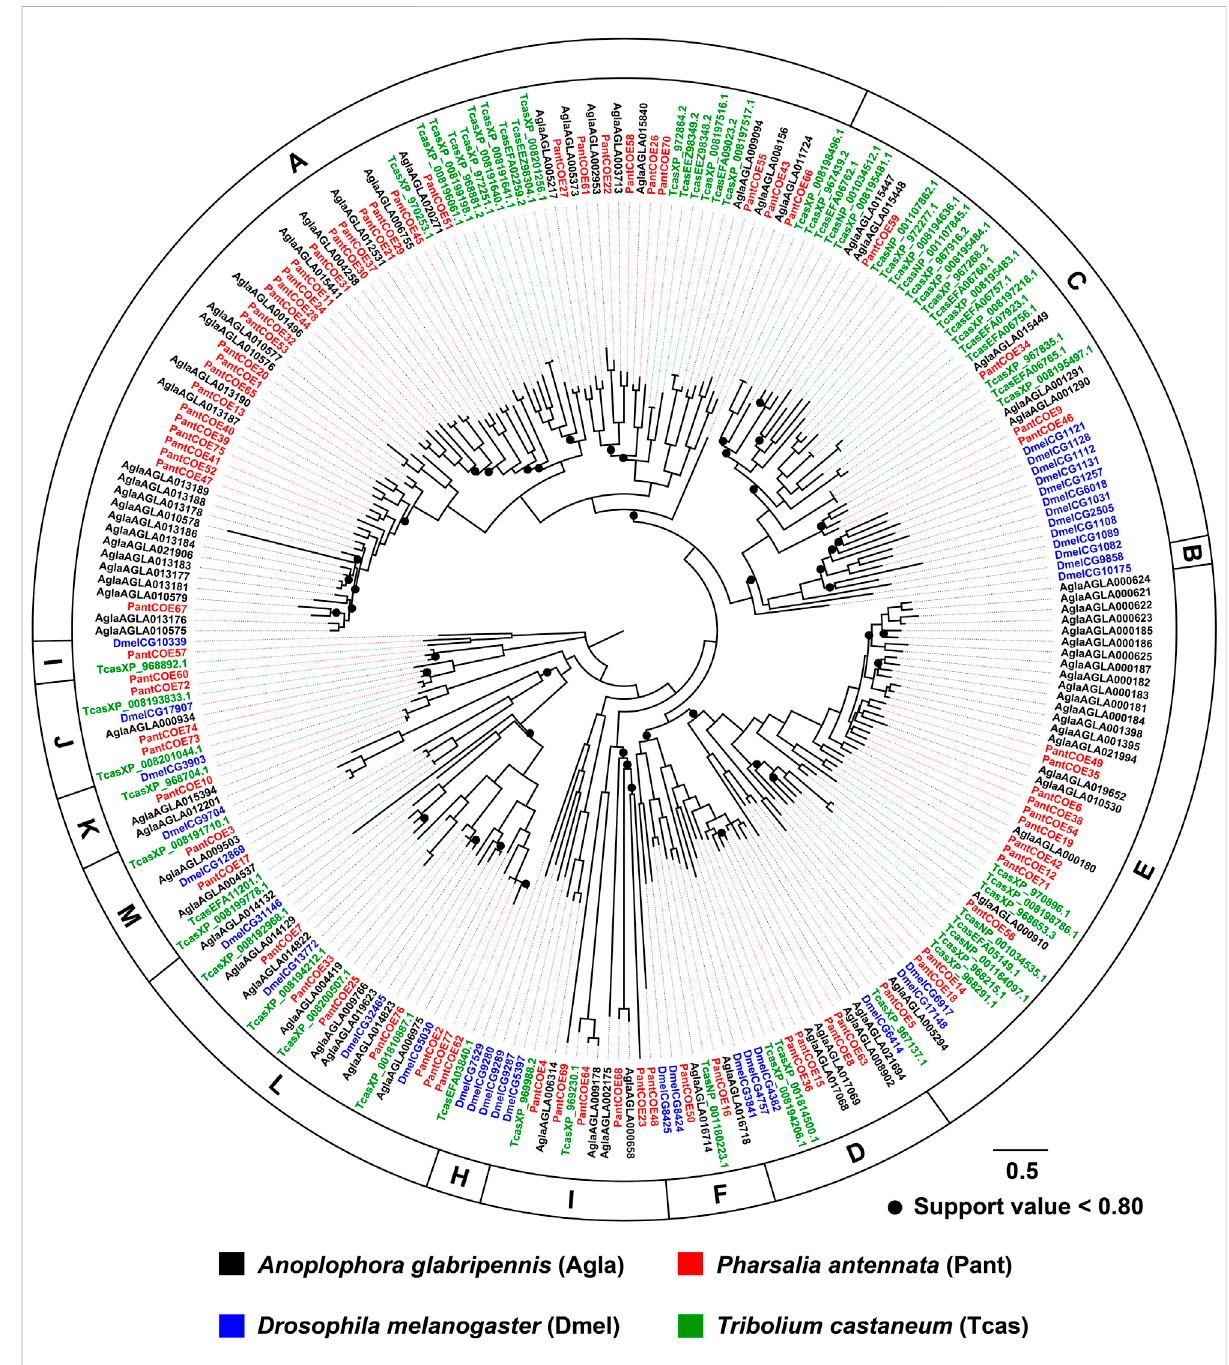
FIGURE 5 Maximum-likelihood tree of COEs in three coleopteran species and D. melanogaster . The P450 proteins in P. antennata are highlighted in